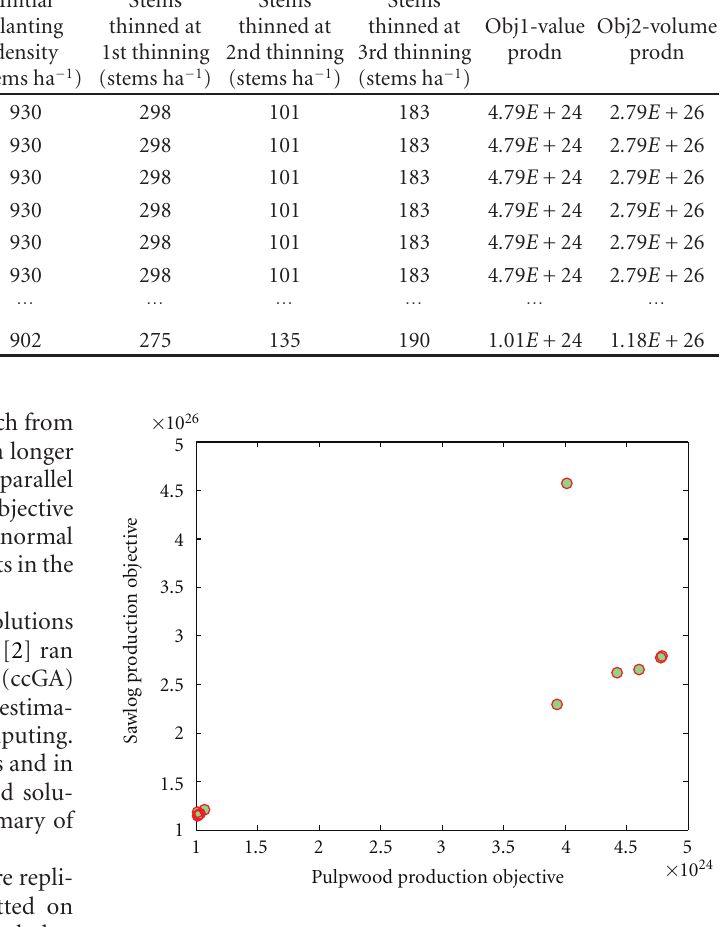
Figure 3: Disjointed Pareto front as predicted by the